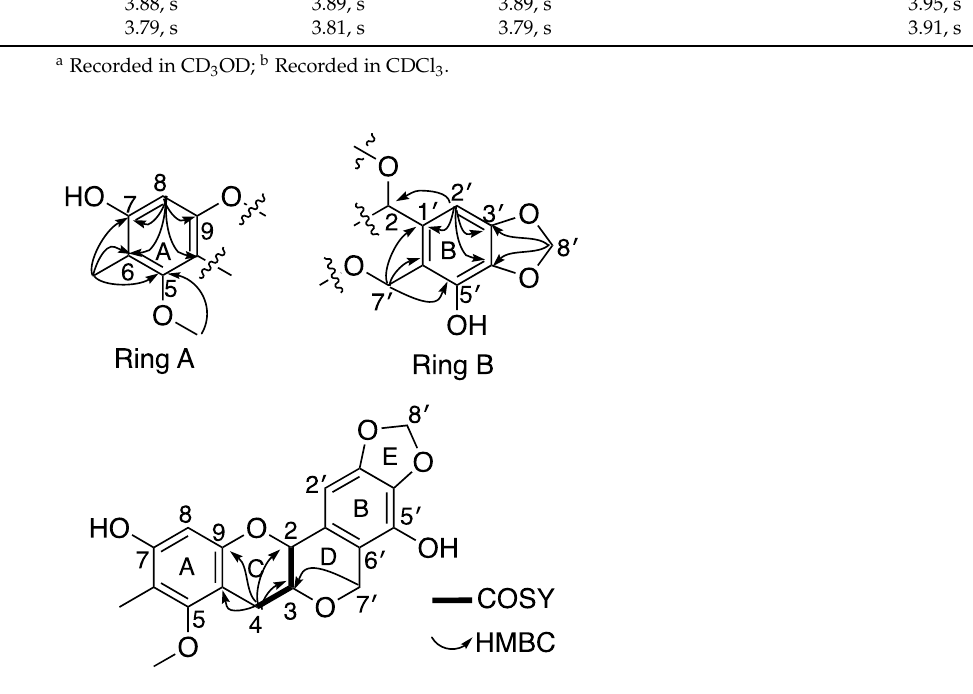
Figure 2. Diagnostic (600 MHz, CD 3 OD) HMBC and COSY correlations of 1. Table 1. 1 H NMR data for compounds 1 – 6.